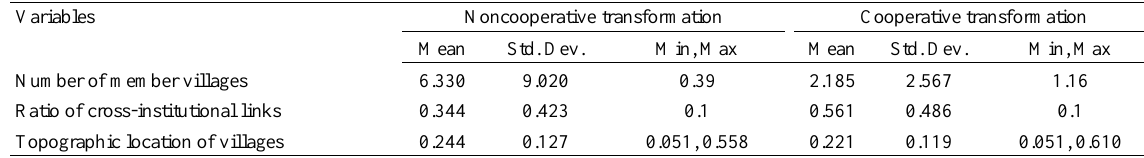
Table 3. Continuous variable statistics by cooperative and noncooperative transformations. For details, see Table 1.